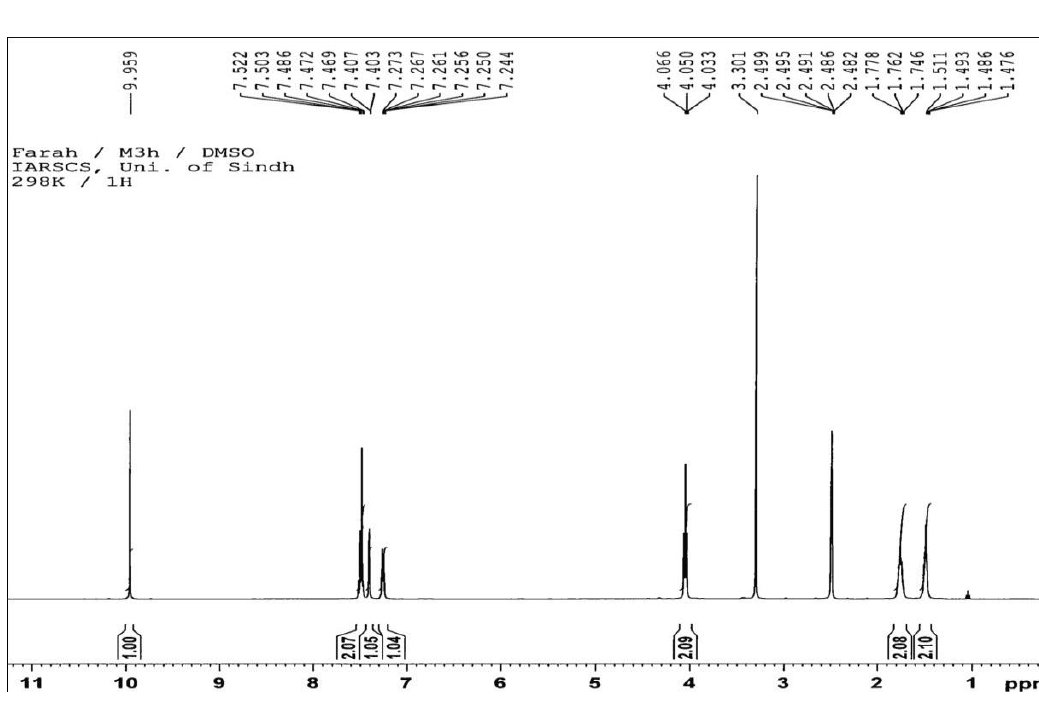
Figure S8: 1 HNMR spectrum of dialdehyde monomer m